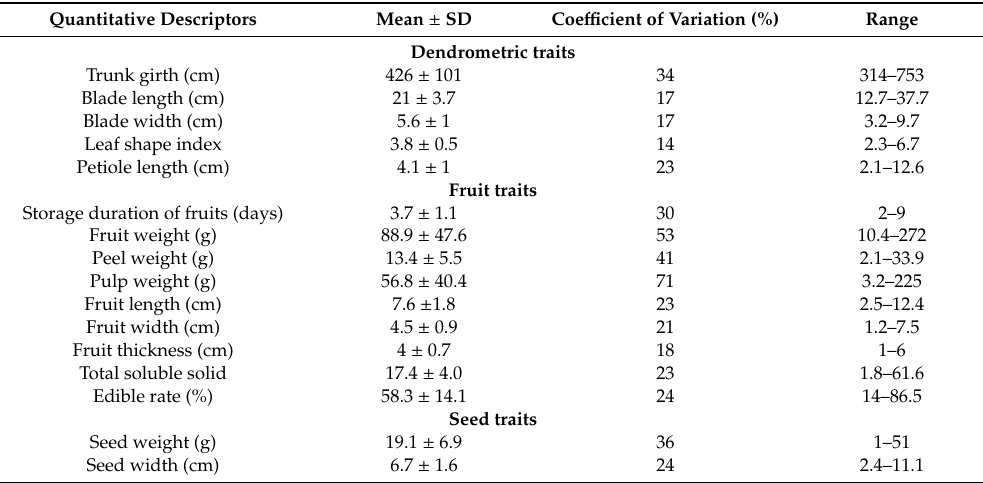
Table 2. Descriptive statistics for the morphological quantitative